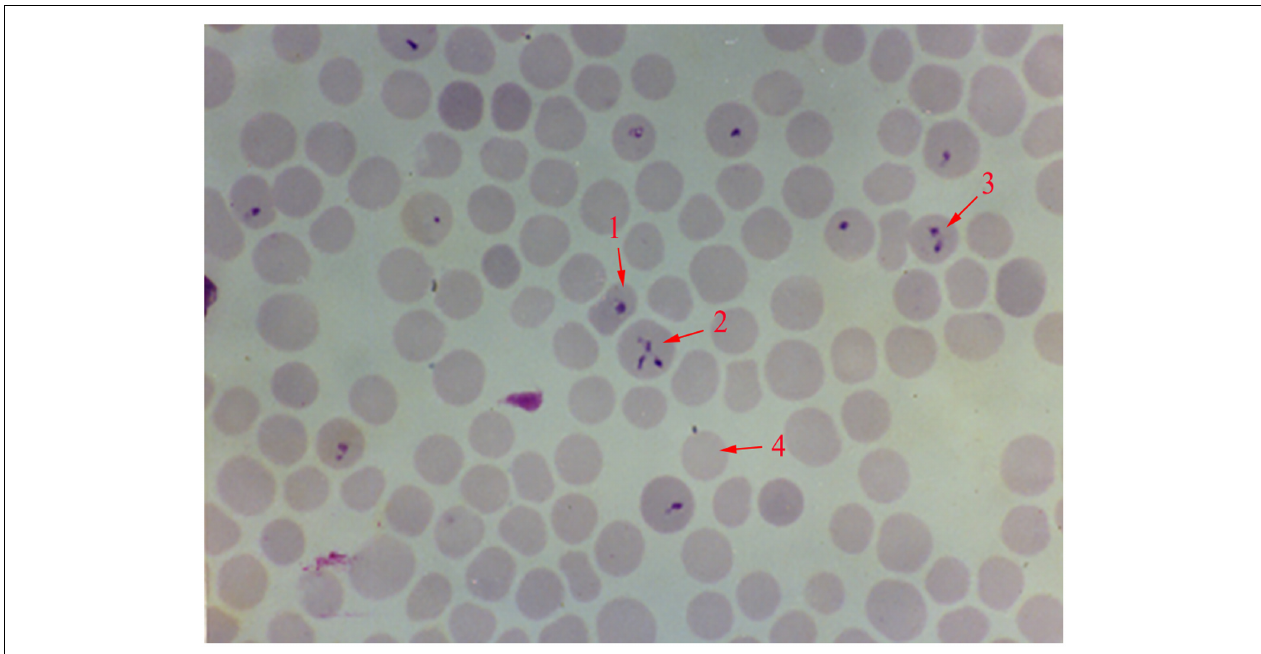
FIGURE 1 | Giemsa stained thin blood smear of Babesia orientalis in water buffalo erythrocytes. Final magnification is 1000 × . 1, single pyriform; 2, multiple parasites infected RBC; 3, double pyriform; 4, exo-erythrocytic